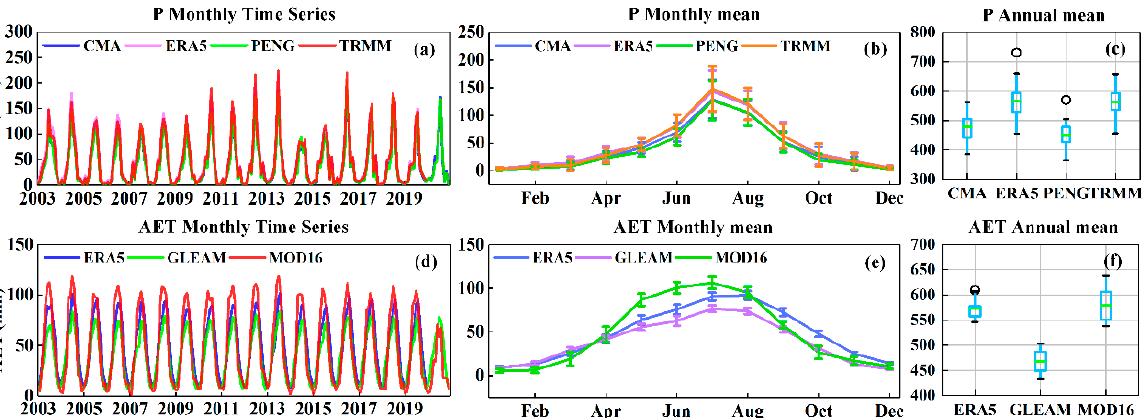
Figure 2. Plots summarizing datasets describing variables. From top to bottom, the panels depict precipitation (P), AET. ( a , d ) represent monthly time series, ( b , e ) represent monthly means, and ( c , f ) represent annual means. Table 1. Summary of data used in the study.